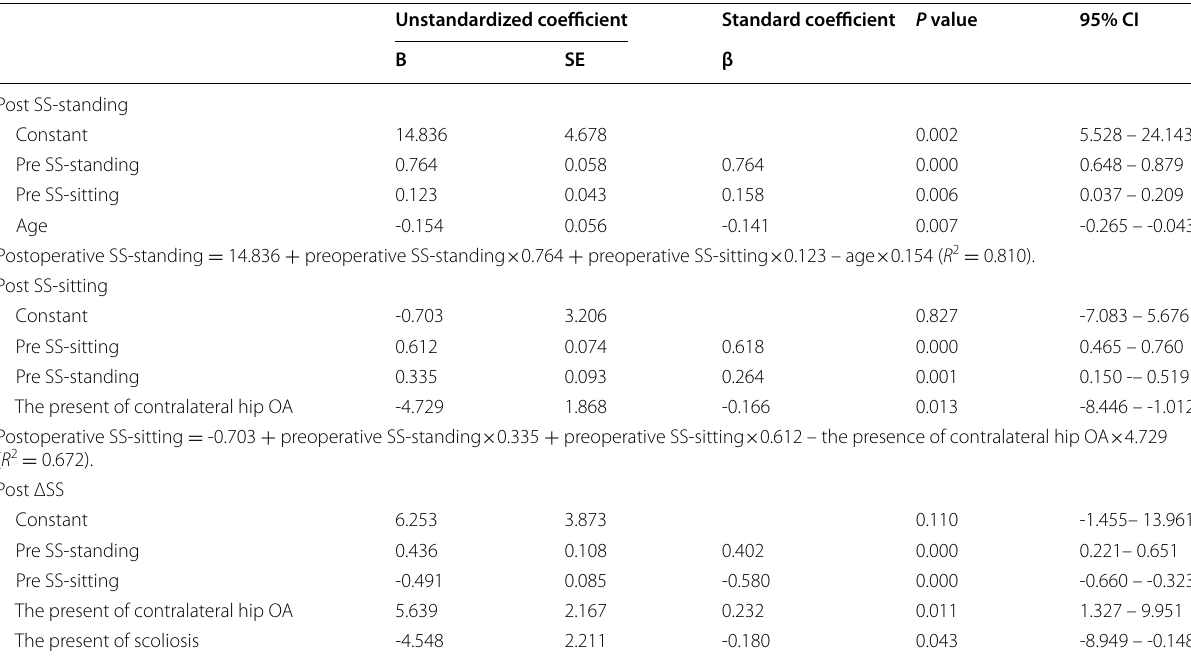
Table 3 Multiple linear regression analysis of postoperative SS in standing